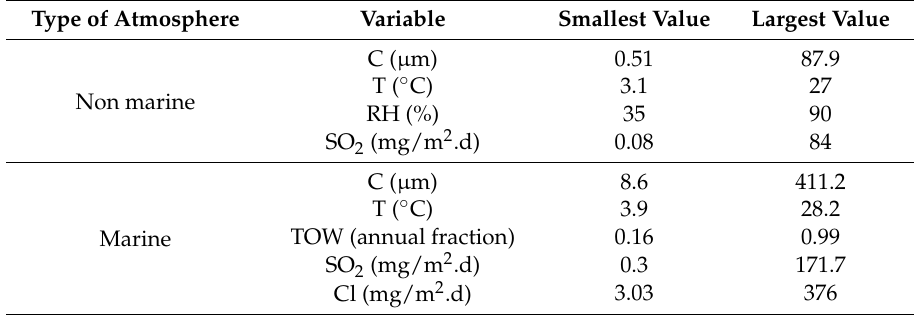
Table 7. Characteristics of the corrosion and environmental data used in the statistical